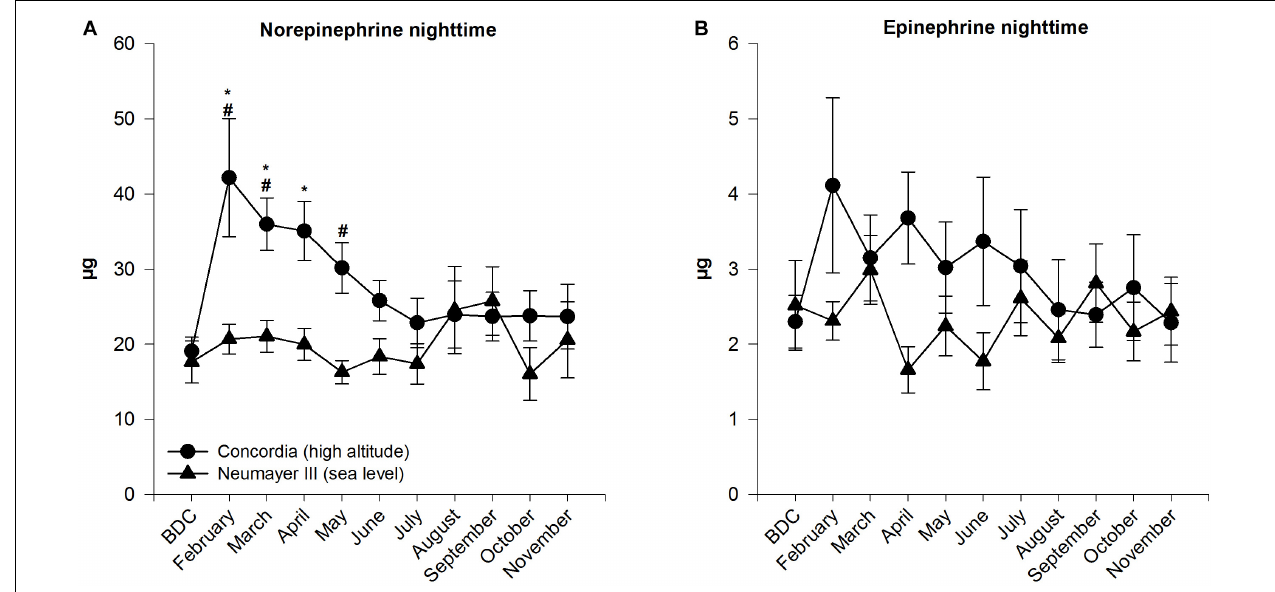
FIGURE 2 | Norepinephrine (A) and epinephrine (B) in 12-h nighttime urine at Neumayer III (sea level) ( n = 11–16) and Concordia (high altitude) ( n = 11–15); data are means ± SEM; units are µ g (collection time 12 h); BDC, baseline data collection; ∗ significant difference to BDC; # significant difference between Neumayer III (sea level) and Concordia (high altitude) crews.